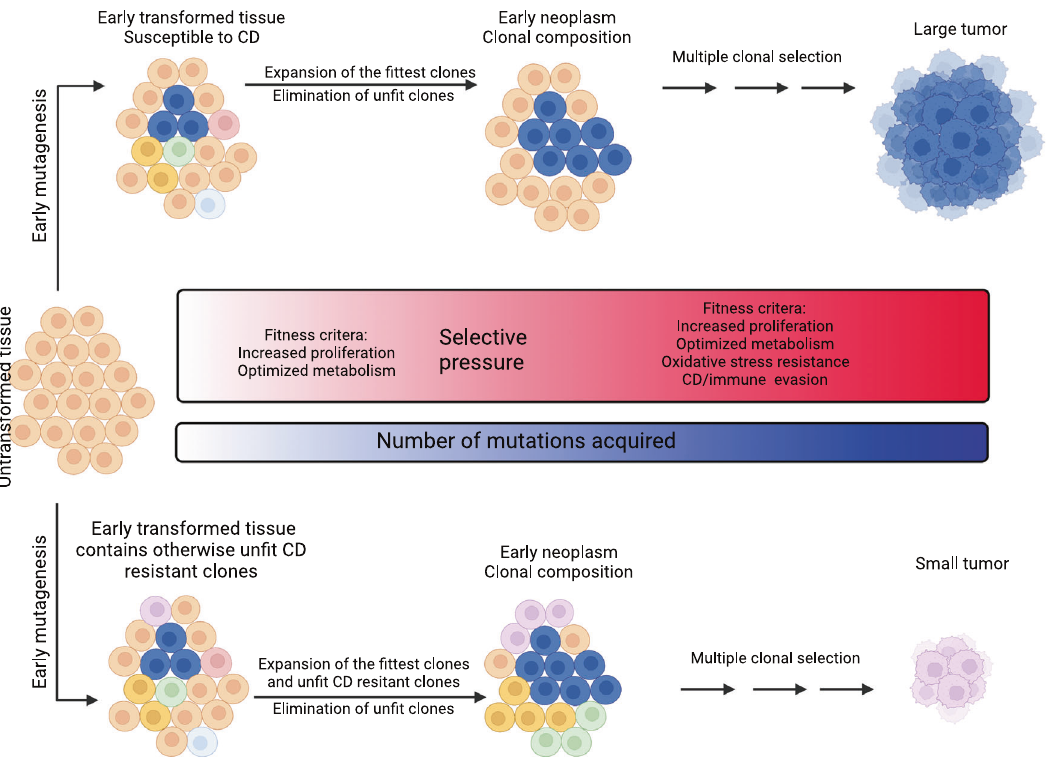
Fig. 1 Cell death resistance in cancer evolution — a double-edged sword? During early tissue transformation, intercellular variations, e.g., in DNA replication and repair, may lead to early transformation through an accumulation of various (driver) mutations. These mutations, in turn, may increase clonal fi tness by increasing proliferation and/or metabolism and hence enable single, advantageous clones to expand and form precursor lesions, while disadvantageous clones may be eliminated through various modes of cell death. Early neoplasm formation is accompanied by a steady increase in selective pressure through increases in oxidative stress and nutrient scarcity, which, in turn, fuels selection for even fi tter clones carrying resistance to oxidative stress, cell death, and/or immune intervention, which may ultimately lead to tumor formation. However, when cell death resistance is induced during early tissue transformation, expansion of otherwise un fi t clones may be enabled. This may ultimately lead to the formation of smaller and less invasive tumors through further rounds of selection. CD cell death. This fi gure was generated using fully licensed